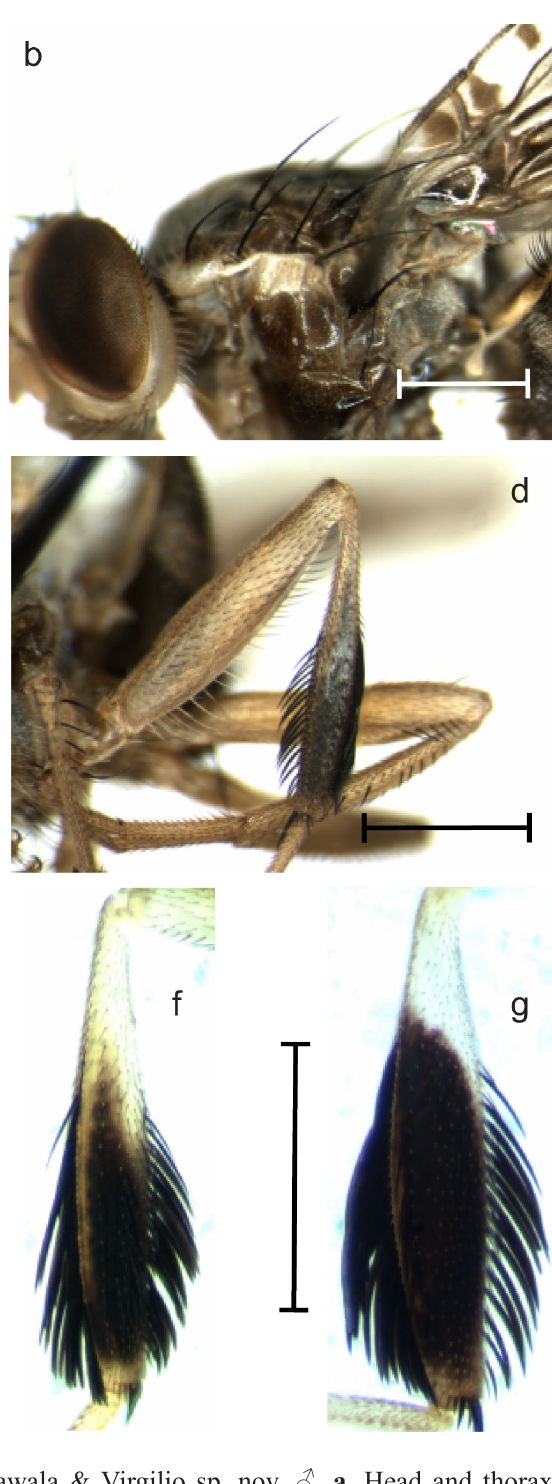
Fig. 1. — a–f . Ceratitis quilicii De Meyer, Mwatawala & Virgilio sp. nov. ♂ . a . Head and thorax, anterodorsal view. b . Head and thorax, lateral view. c . thorax, dorsal view. d . Midleg, anterior view. e . wing. f . Midtibia, anterior view. — g . C. rosa Karsch, 1887 s.str. midtibia, anterior view. Scale bars = 1